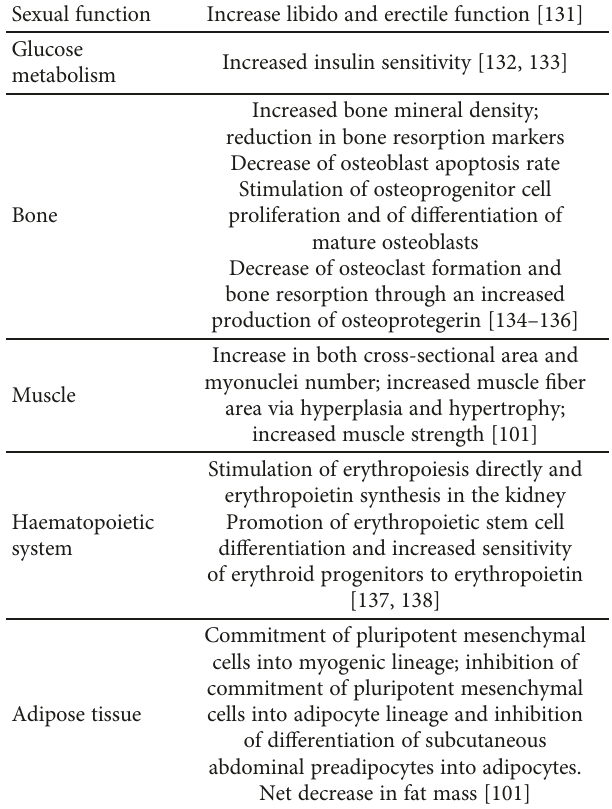
Table 2: Endocrine roles of T in the human